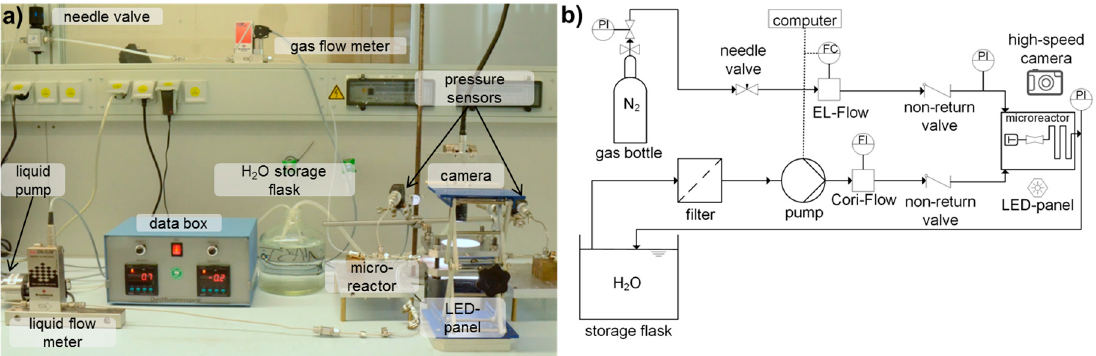
Figure 6. ( a ) Experimental set-up for energy-efficient turbulent bubble breakup investigations; ( b ) accompanying flow chart.